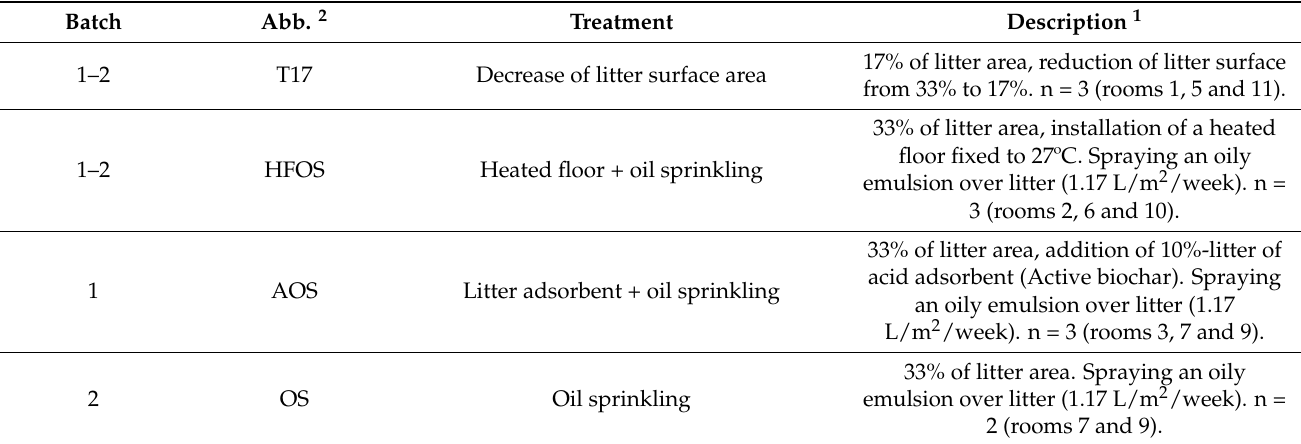
Table 1. Environmental control strategies (ECS) applied at the experimental cage-free systems (CFS). Batch Abb. 2 Treatment Description